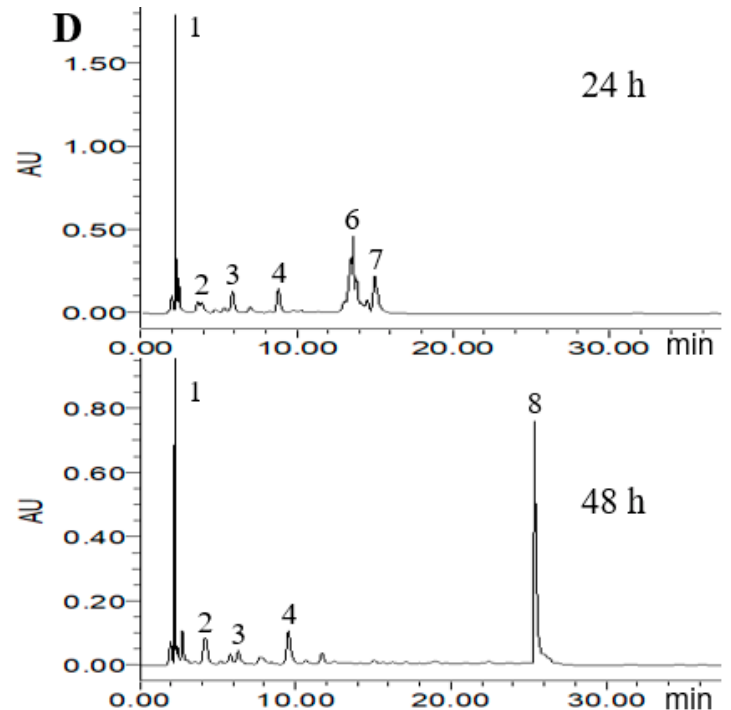
Figure 4. High Performance Liquid Chromatography (HPLC) chromatogram of PLSE fermented by probiotic bacteria at 37 ◦ C for 24 h and 48 h. Control ( A ), Lactobacillus reuteri DSM20016 ( B ), Enterococcus faecalis M74 ( C ), Bifidobacterium breve ATCC 15701 ( D ). Peaks: 1, 2.2 min; 2, 3.8 min; 3, 6.3 min; 4, 8.2 min; 5, 10.9 min; 6, 13.3 min; 7, 14.7 min; 8, 25.7 min.